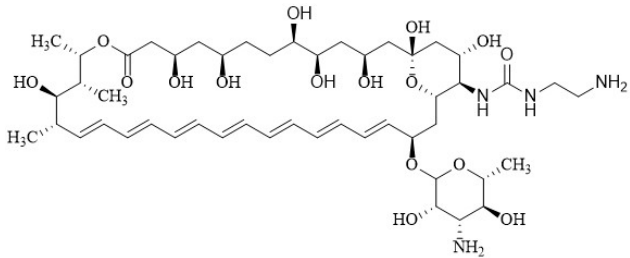
Figure 10. Chemical structure of AmB urea derivative 7 .